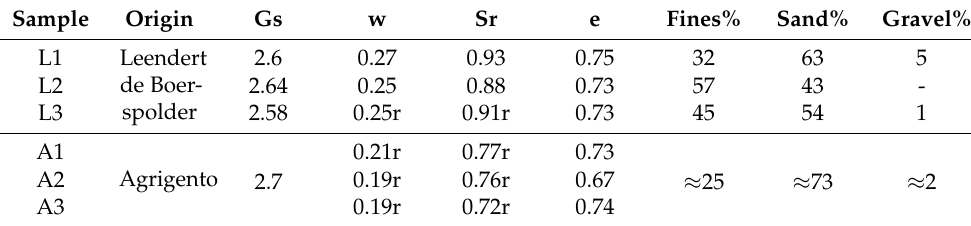
Table 1. Samples investigated for water retention. In the table, r stands for reconstituted.